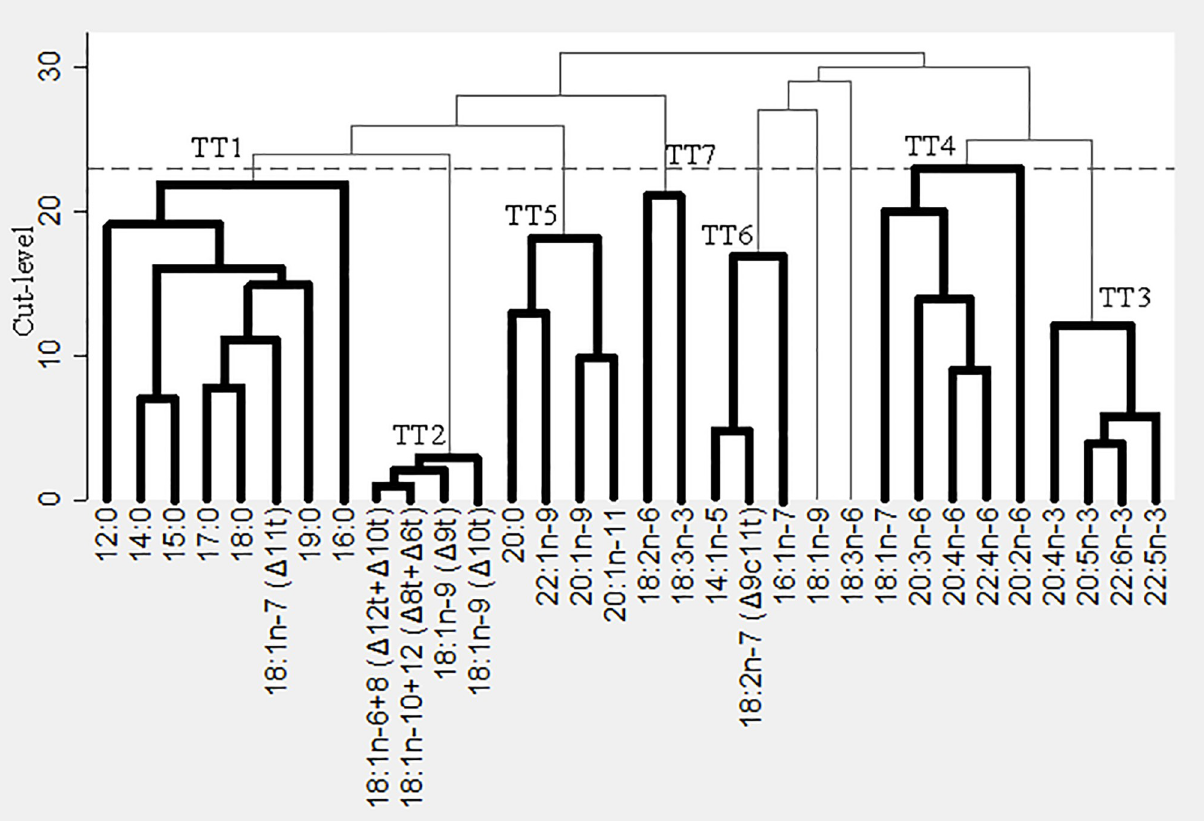
Fig 2. Treelet transform dendrogram of the 32 fatty acids in adipose tissue determined in the subcohort (n = 3,130). The horizontal line indicates the optimal cut at level